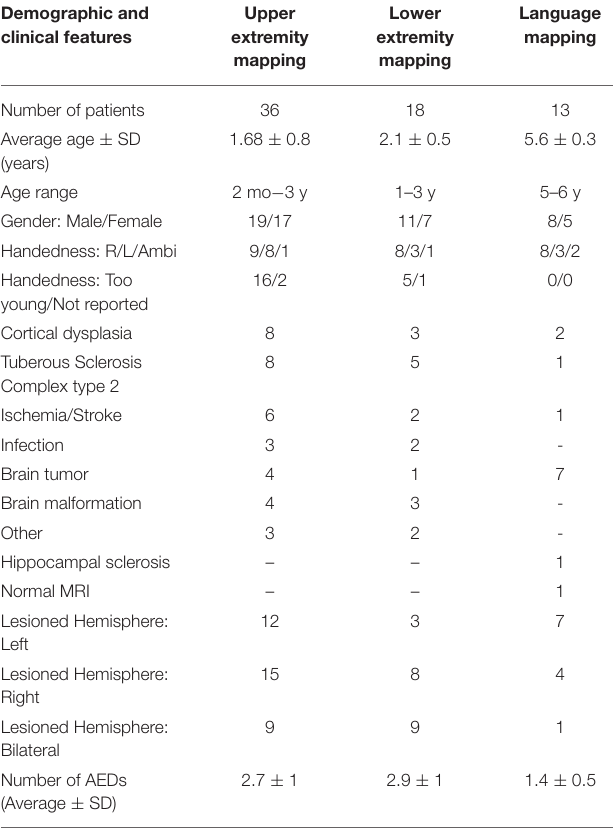
TABLE 1 | Demographic and clinical parameters in the motor and language mapping cohorts. Demographic and clinical